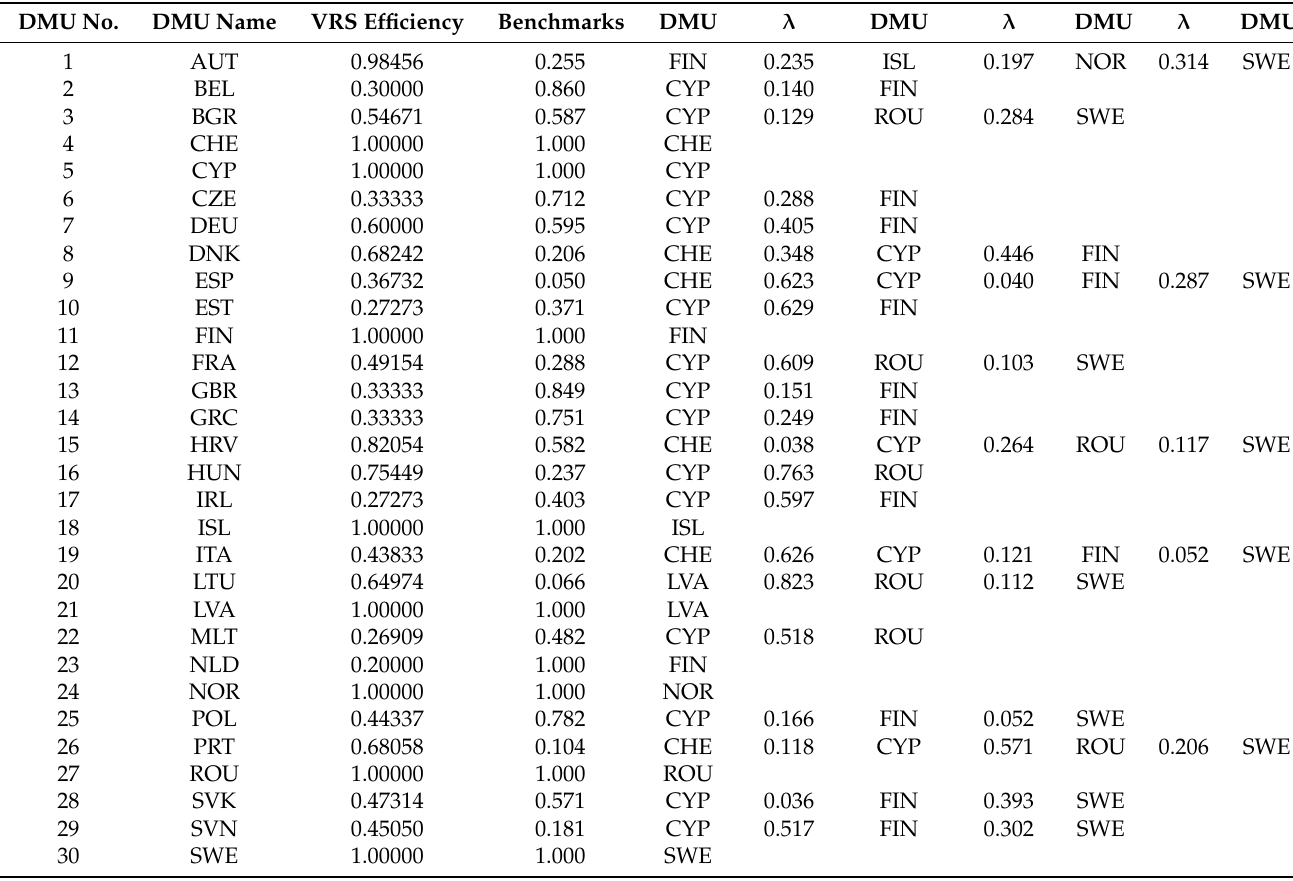
Table A14. Input-Oriented VRS Efficiency of EPS in 2008. Source: Authors’ calculations in DEAFrontier. DMU